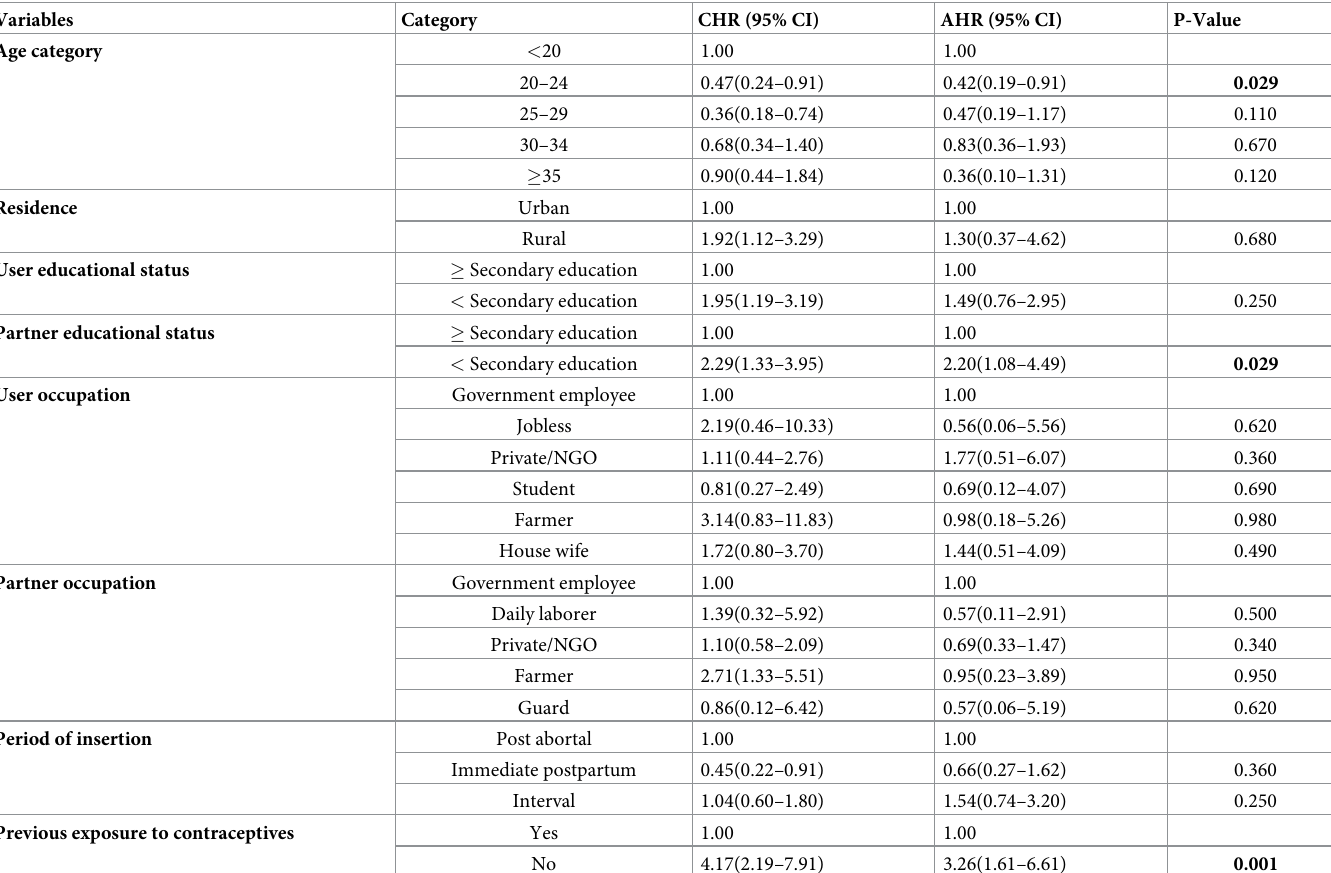
Table 3. Cox regression analysis for predictors of unplanned discontinuation of Implanon at Ayder comprehensive specialized hospital, Mekelle, Northern Ethio- pia, 2016–2017 (n =